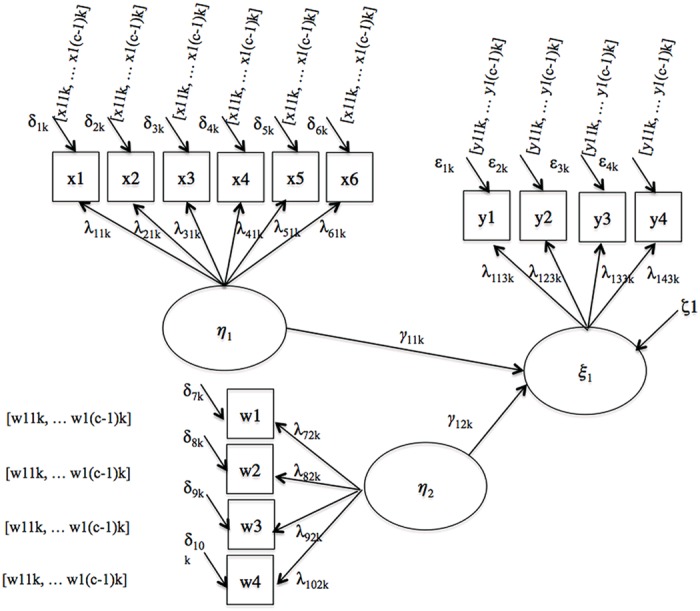
Partial regression.